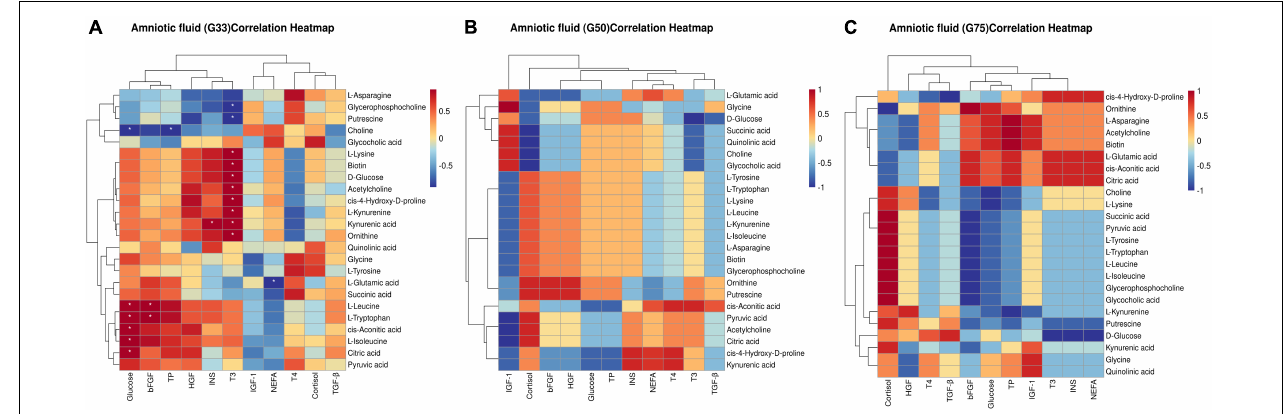
FIGURE 6 | Correlation between biochemical parameters/physiological hormones and differential metabolites in amniotic fluid at different gestation stages: (A) G33; (B) G50; (C) G75. The correlation coefficient is represented by different colors (red, positive correlation; blue, negative correlation). *represents significant negative or positive correlations (* P <